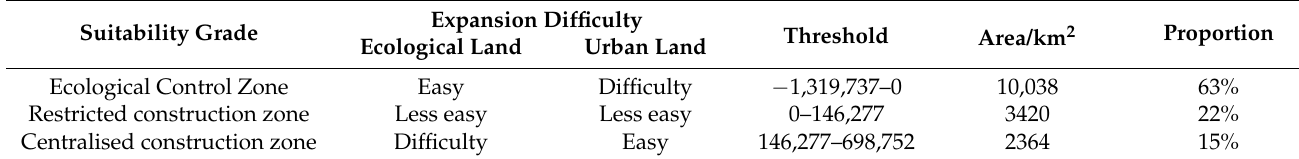
Figure 6. Ecological suitability zoning in Beijing. Table 2. Ecological suitability zone of